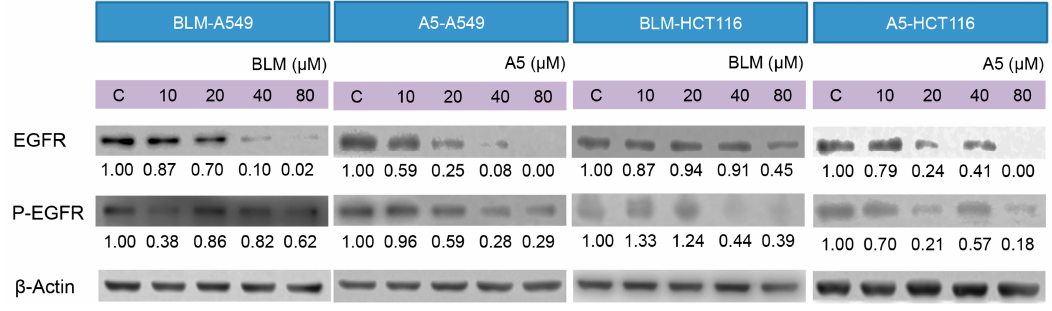
Figure 6. Effects of BLM and A5 on epidermal growth factor receptor (EGFR) and phosphorylated-EGFR in A549 and HCT116 cells. Cells were seeded in 10-cm dishes for 24 h followed by treating with serial concentrations of BLM and A5 (0, 10, 20, 40, 80 μ M) for another 24 h. The cells were then harvested for immunoblot analysis as described in the Materials and Methods section. The numbers underneath the blots represent band intensity (normalized to β -Actin, the means of three independent experiments) measured by Image J software. The standard deviations (all within ±15% of the means) were not shown. β -Actin was served as an equal loading control. The experiments were repeated three times.